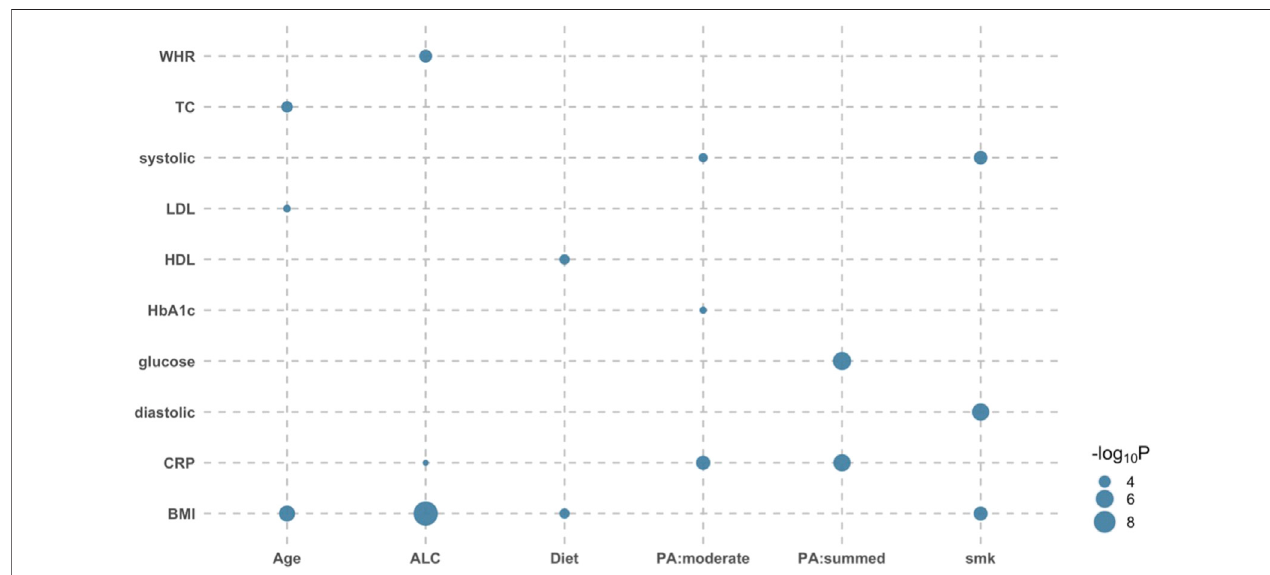
FIGURE 1 | Bubble plot of p -values indicating signi fi cant orthogonal GxE interactions. There were 16 signi fi cant orthogonal GxE interactions when testing the genetic effects of 12diabetes-related metabolic traits modulated byeight covariates. Likelihood ratiotests were used to compare the fullmodel withthe RxEonly model for each ofsixindependentdatasets,and p -valuesweremeta-analyzedusing theFisher method. Thesizeofdotre fl ects its signi fi cance; thebigger themore signi fi cant. Forexample,theBMI-ALCpairismostsigni fi cant( p -value=1.86E-10),indicatingthatALCsigni fi cantlymodulatesgeneticeffectsofBMIphenotypes.WHR,waist- hip ratio; TC, Total cholesterol; systolic, systolic blood pressure; sodium, sodium in urine; potassium, potassium in urine; LDL, low density lipoprotein cholesterol; HDL, high density lipoprotein cholesterol; HbA1c, haemoglobinA1C; CRP, C reactive protein; BMI, body mass index; Age, Age at recruitment; ALC, alcohol intake frequency; smk, smoking status; PA:summed, a summed physical activity; PA:walk, physical activity walking; PA:moderate, physical activity moderate intensity; PA:vigorous, physical activity vigorous intensity; Diet, healthy dietary